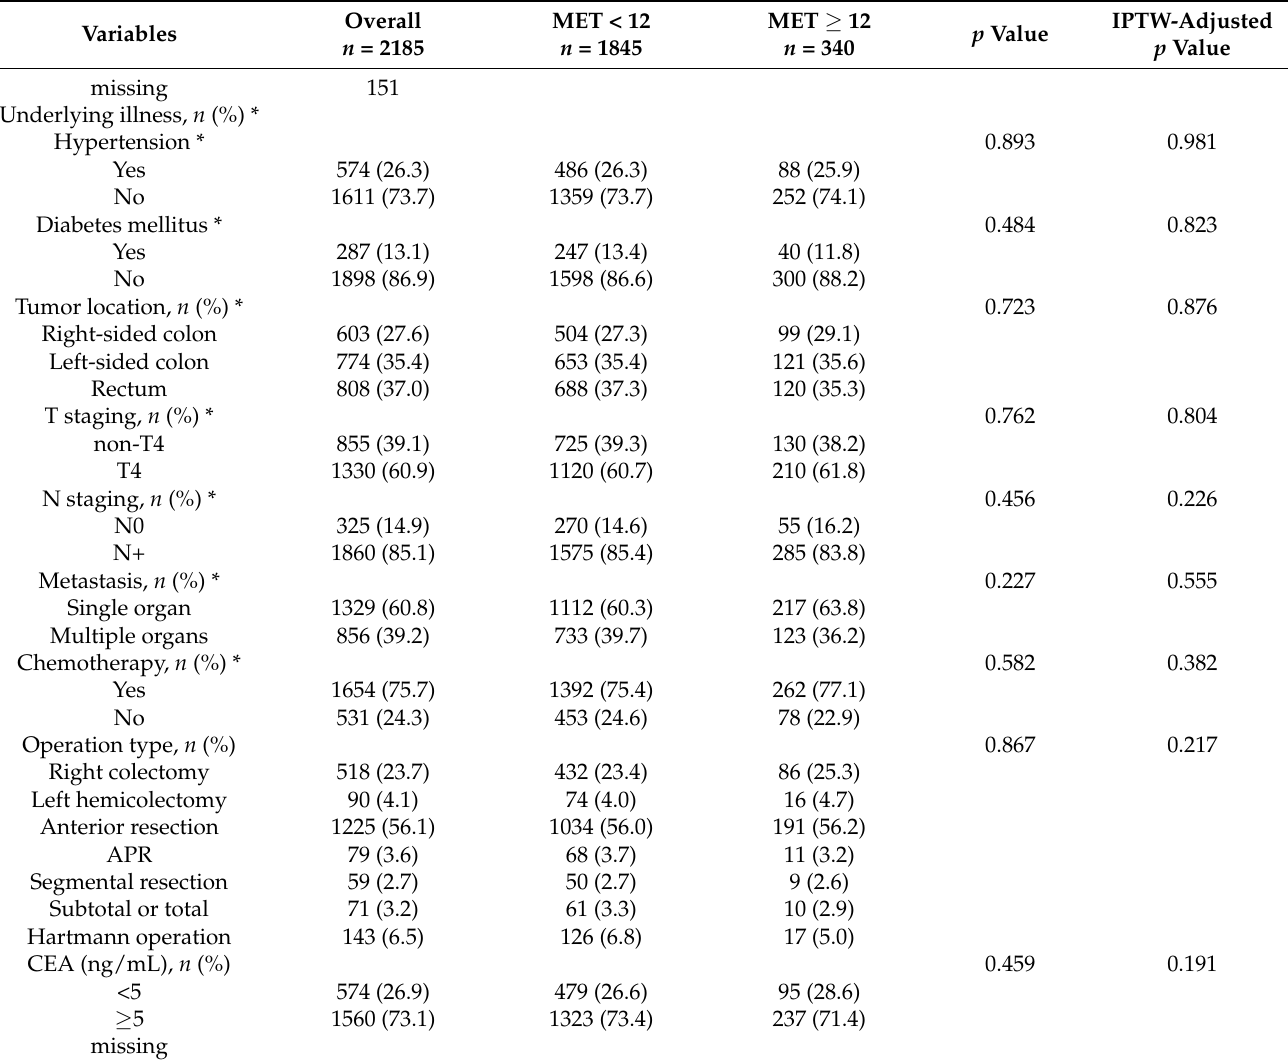
Table 2 revealed the short-term postoperative outcomes. After the IPTW process, the MET < 12 group showed a higher postoperative morbidity rate than the MET ≥ 12 group (18.7% vs. 10.6%; p < 0.001). The MET < 12 group had a higher rate of wound infection (3.5% vs. 1.5%; p < 0.001), lung complications (1.3% vs. 0.6%; p = 0.043), and gastrointestinal complications, such as postoperative ileus (4.2% vs. 1.8%; p < 0.001). There are no significant differences in cardiovascular-, urinary tract-, or intra-abdominal-related complications or anastomosis between the groups. The postoperative mortality rate was higher in the MET < 12 group than in the MET ≥ 12 group (2.4% vs. 0.6%; p < 0.001). In the severity of complications assessed by modified Clavien–Dindo classification, the MET < 12 group had a higher proportion of both low-grade (I/II) postoperative complications (12.8%